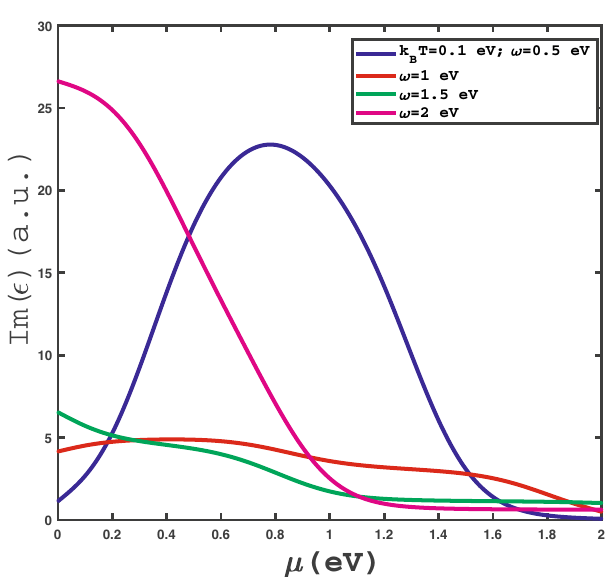
Figure 4. Optical absorption, Im (ǫ) , of doped MoS 2 layer as a function of chemical potential µ at fixed 0.1 eV for different values of frequency ω in the absence of temperature k B T =